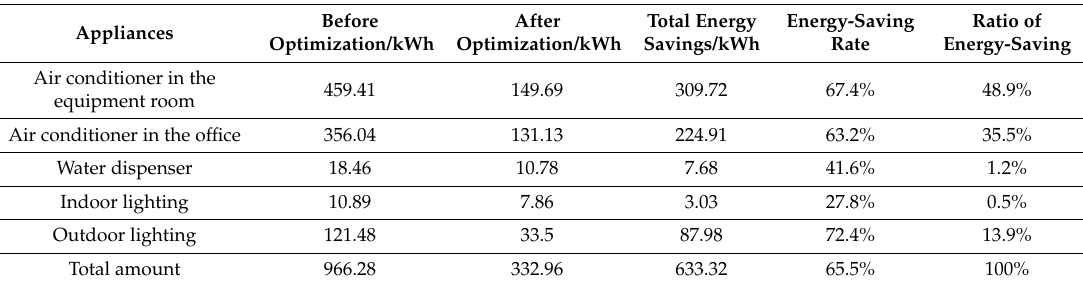
Table 4. Energy saving statistics.